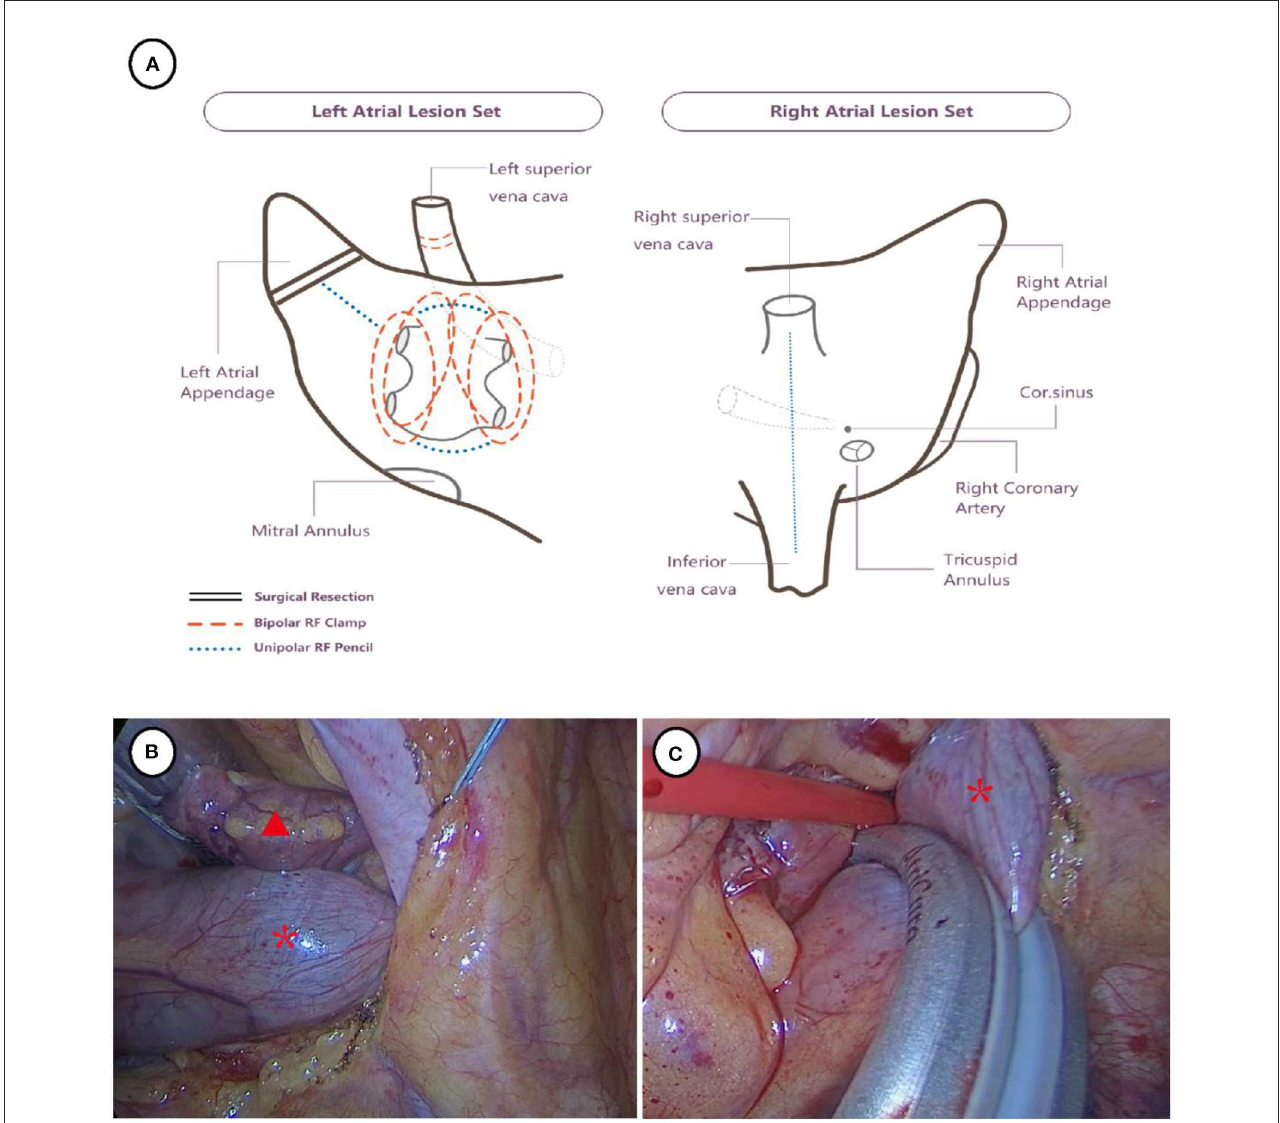
FIGURE2 Surgical strategy (A) and thoracoscopic view of left atrial appendage excision and ablation of PLSVC (B, C) . The red triangle indicates left atrial appendage and the red asterisk indicates